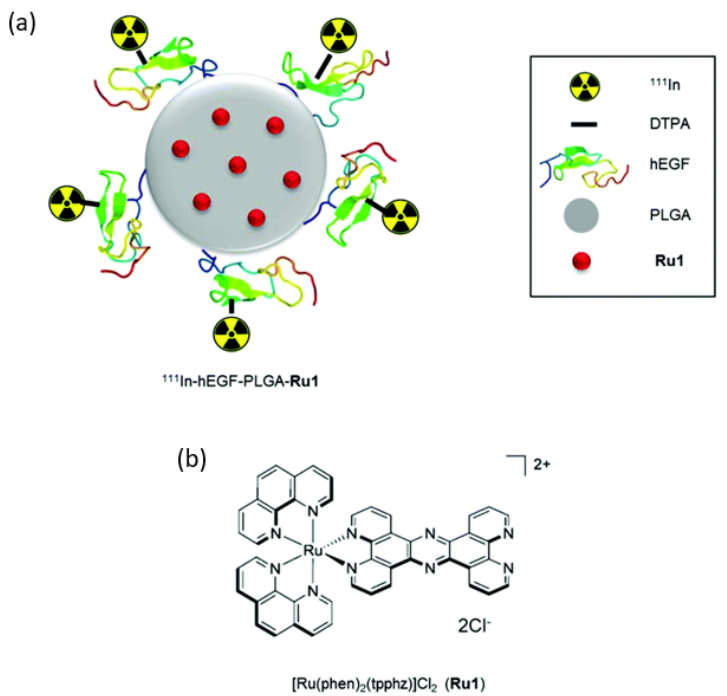
Figure 6. ( a ) Schematic representation of radiolabeled nanoparticles; ( b ) Chemical structure of Ru1. Reprinted from an open-access source [268].